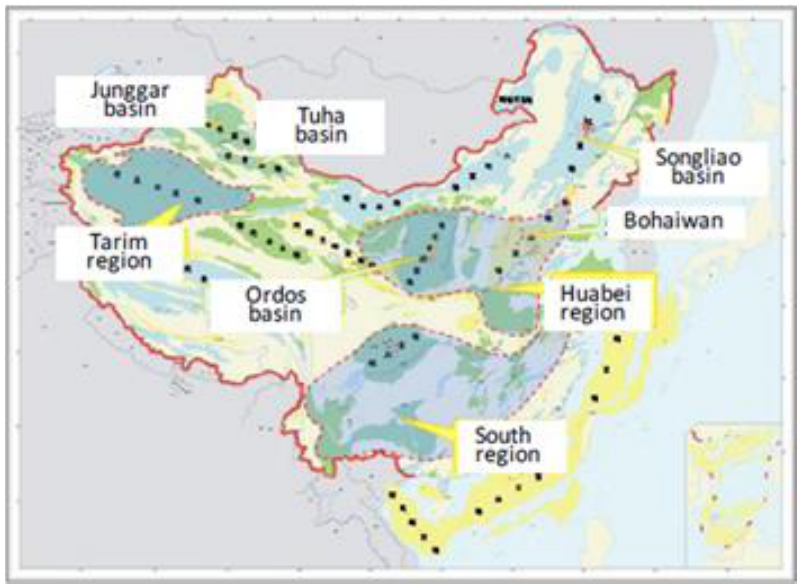
Figure 5. Distribution map of favorable exploration areas for shale gas in China.